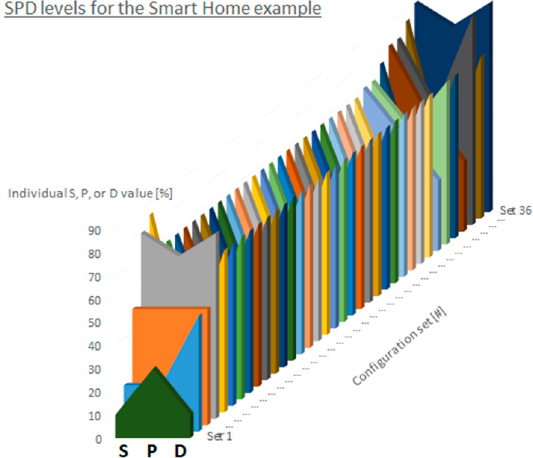
Figure 5. The SPD level of the 36 possible system configurations.